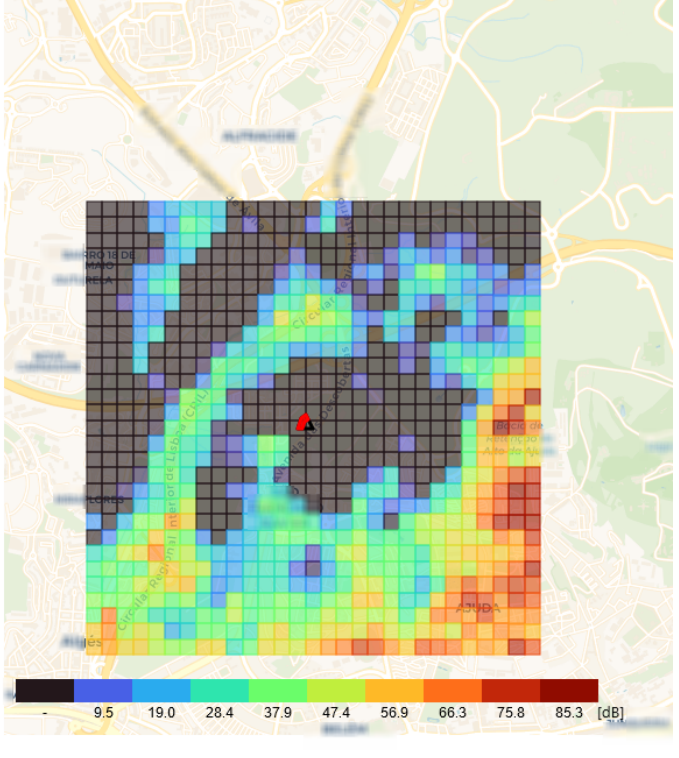
Figure 18. Diffraction losses using the coverage estimation